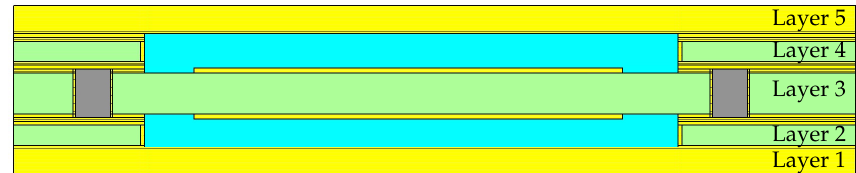
Figure 2. Cross section of the line (the propagation direction is normal to the image). Yellow is copper, green is substrate, gray is plated through holed, and blue is liquid crystal.